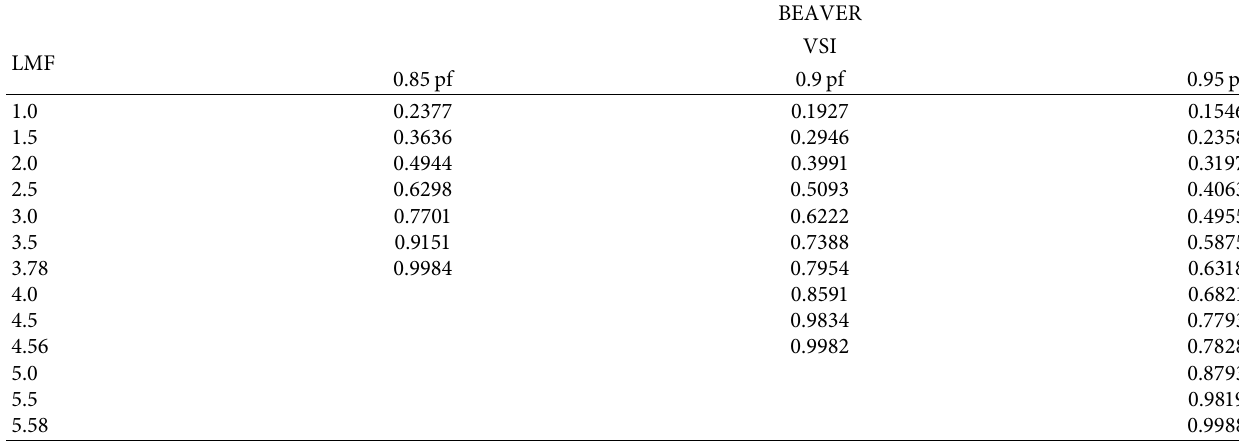
Table 4: Stability points of the BEAVER conductor.